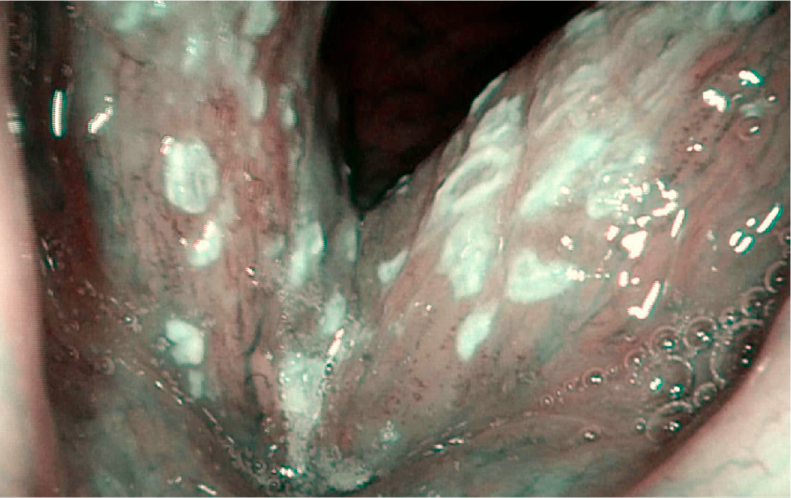
Figure 9. Histologically-verified squamous cell carcinoma presenting as leukoplakia of both vocal cords. IPCLs can be seen around leukoplakia. Ni classification of laryngeal leukoplakia—type III– IV.